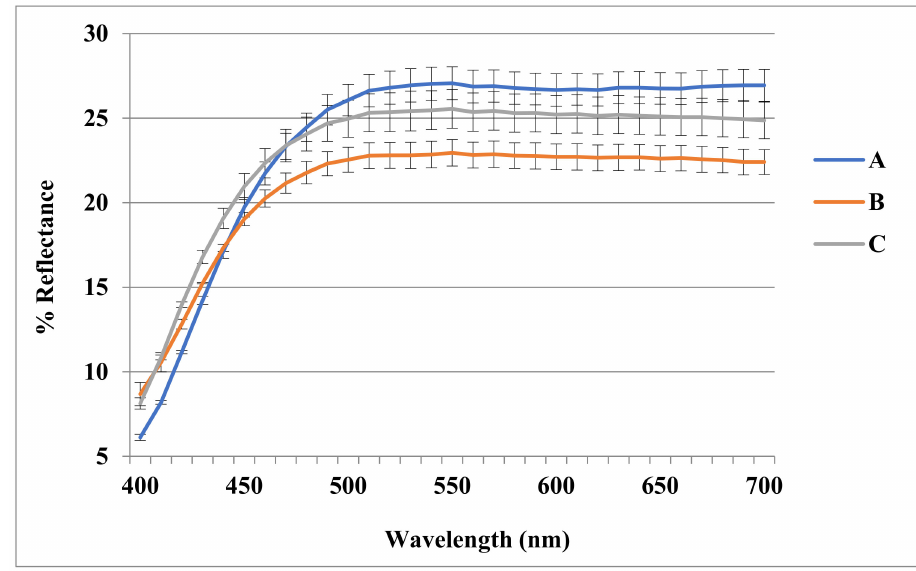
Figure 1. Reflectance curves of hemp essential oils. (A) EC essential oil; (B) CS essential oil; (C) F75 essential oil. Table 5. Gas Chromatography/Mass Spectrometry (GC/MS) analysis of the hemp